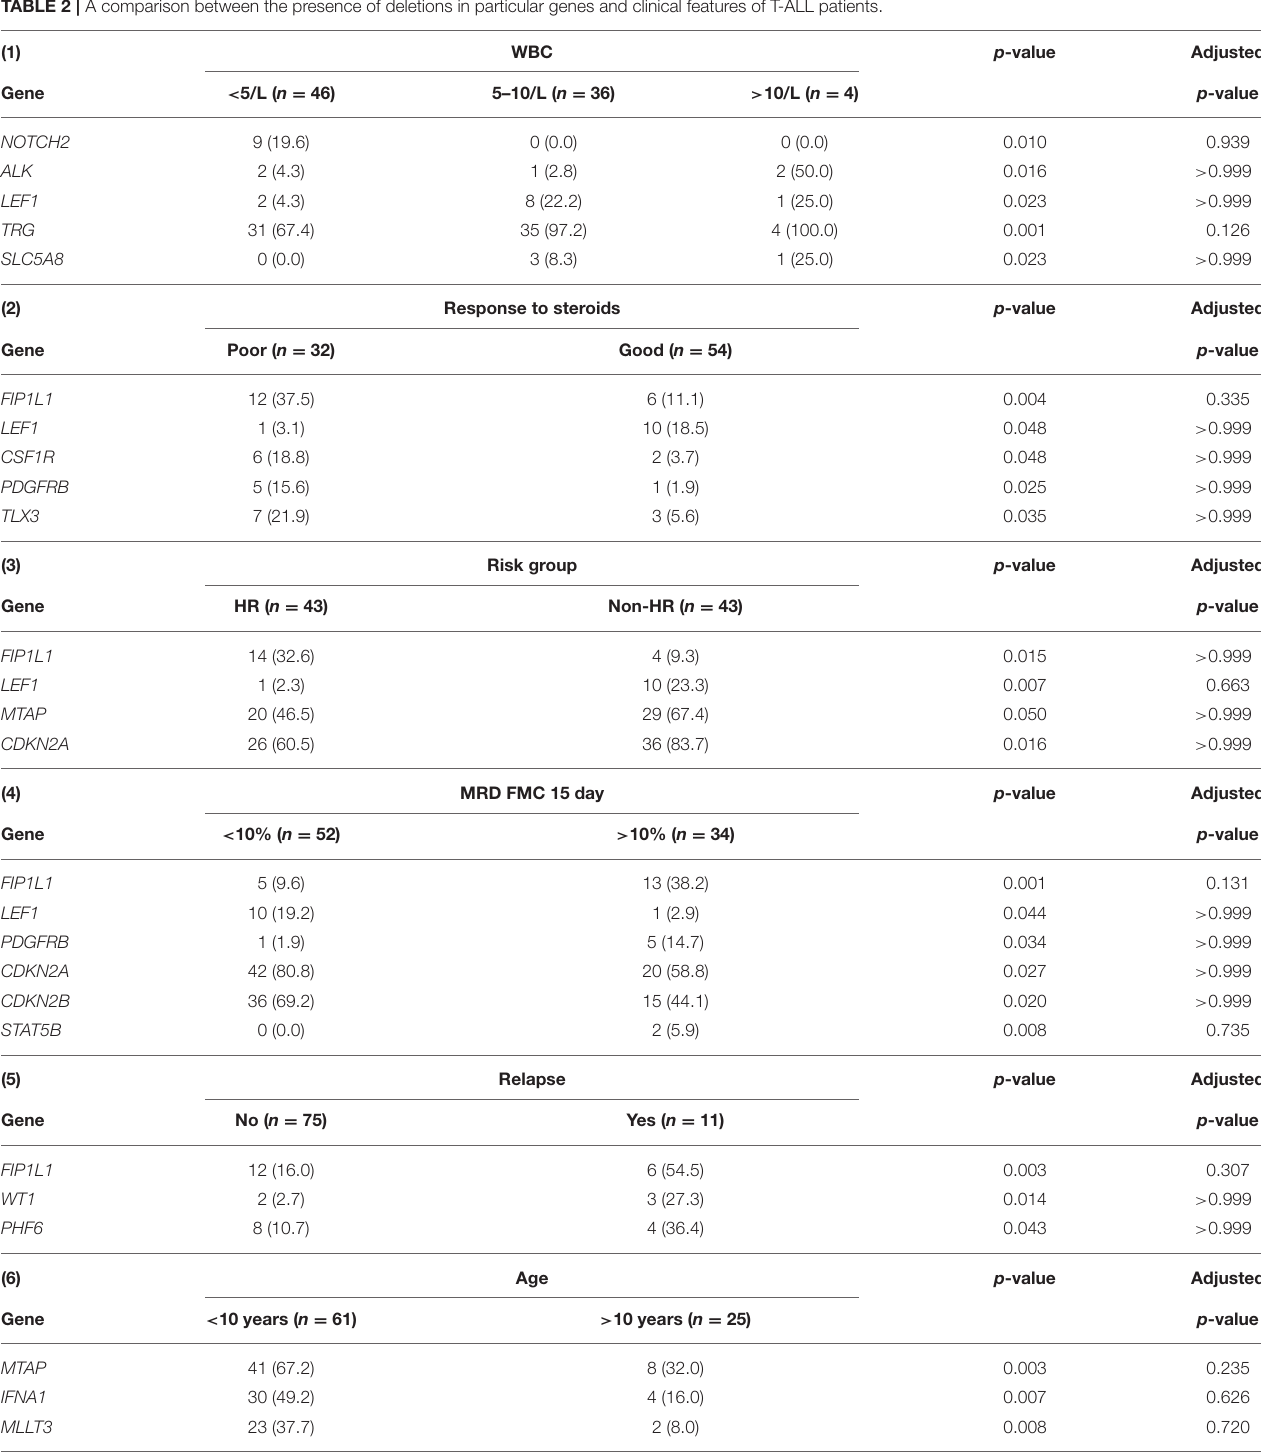
TABLE 2 | A comparison between the presence of deletions in particular genes and clinical features of T-ALL patients.